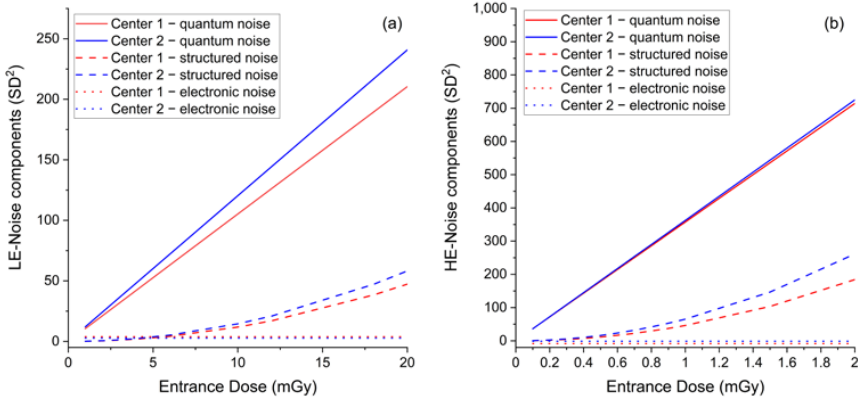
Figure 3. ( a ) Comparison between LE-noise components as a function of ED between the two centers. ( b ) Comparison between HE-noise components as a function of ED between the two centers.